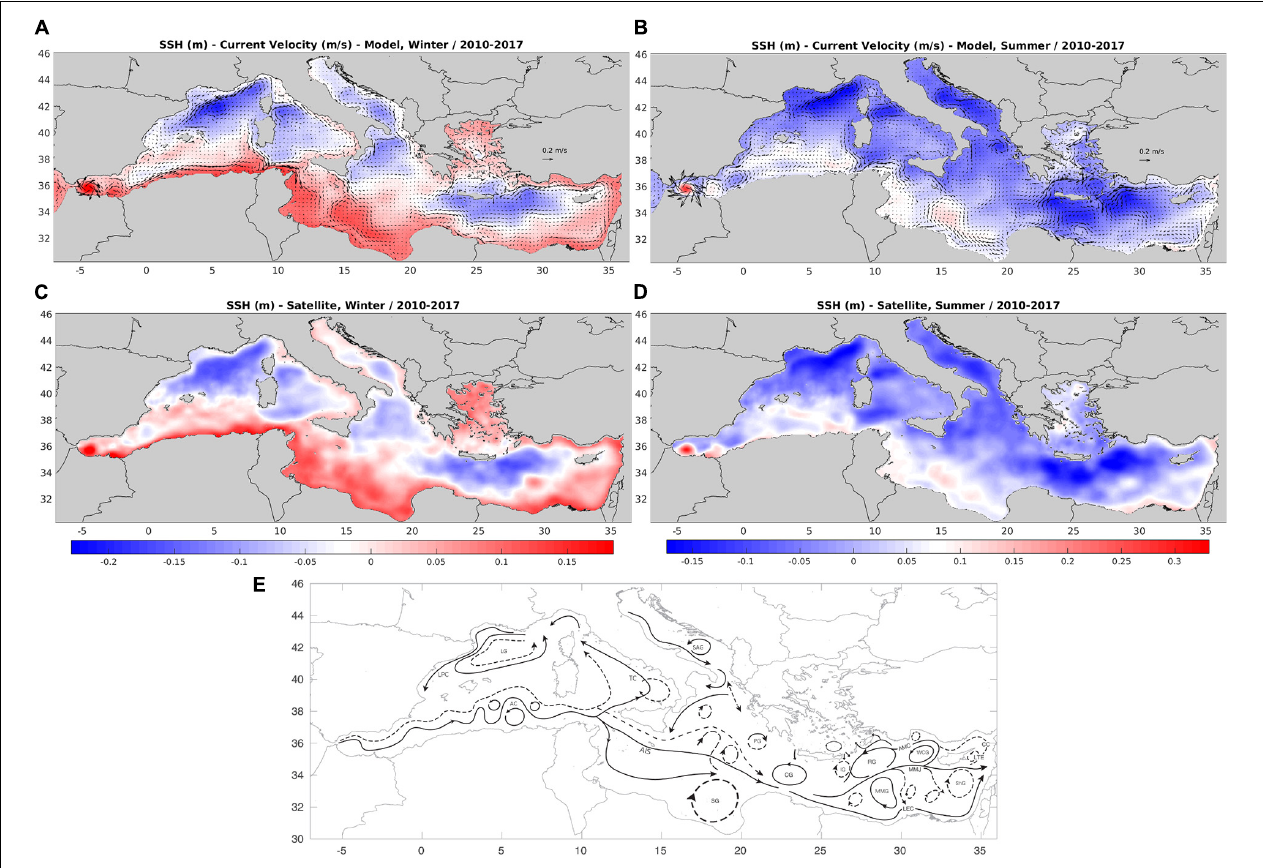
FIGURE 4 | Mean (2010–2017) model simulated (A) winter and (C) summer mean surface current velocity and sea surface height (m), against (B) winter and (C) summer satellite sea surface height. A schematic of Mediterranean surface circulation (continuous line = winter, dashed line = summer) from previous observation and modeling studies (Theoharis et al., 1999; Pinardi and Masetti, 2000; Menna et al., 2012) is also shown in (E) . LG, Lion gyre; LPC, Liguro-Provencal current; AC, Algerian current; TC, Tyrrhenian cyclonic circulation; SAG, South Adriatic gyre; AIS, Atlantic-Ionian stream; CG, Western Cretan gyre; SG, Gulf of Syrte anti-cyclone; PG, Pelops gyre; IG, Ierapetra gyre; RG, Rhodes gyre; MMG, Mersa-Matruh gyre; MMJ, Mid-Med. Jet; ShG, Shikmona gyre; LTE, Latakia eddy; CC, Cilician current; AMC, Asia-Minor current; WCG, Western Cyprian eddy; LEC, Libyo-Egyptian